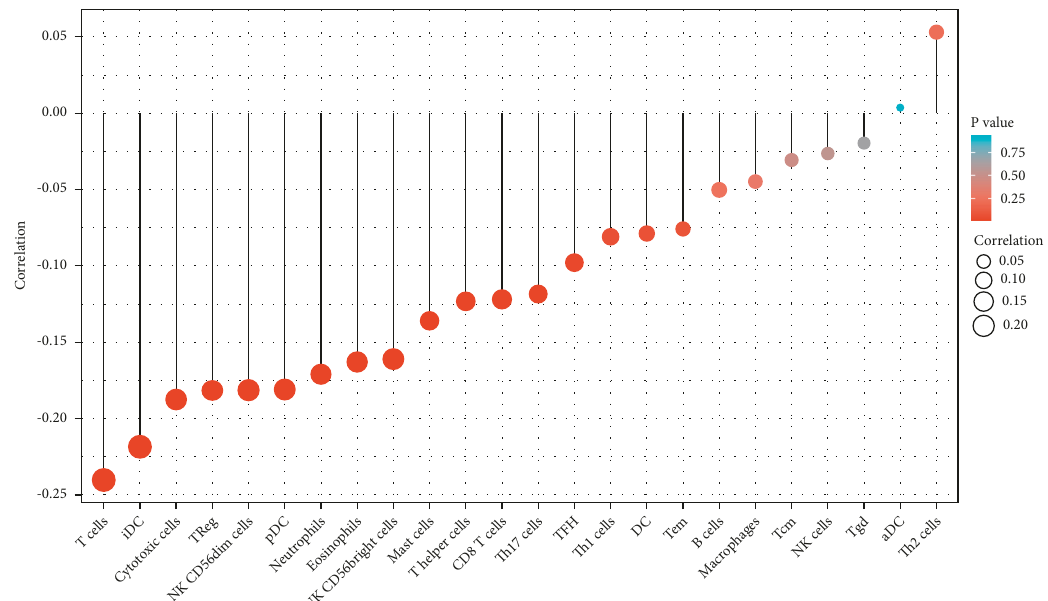
Figure 9: Correlation between miR-149-3p expression and 24 immune cells in UCEC (grouped comparison plots). Significance markers: ∗ P < 0 . 05; ∗ ∗ P < 0 . 01; ∗ ∗ ∗ P < 0 . 001.